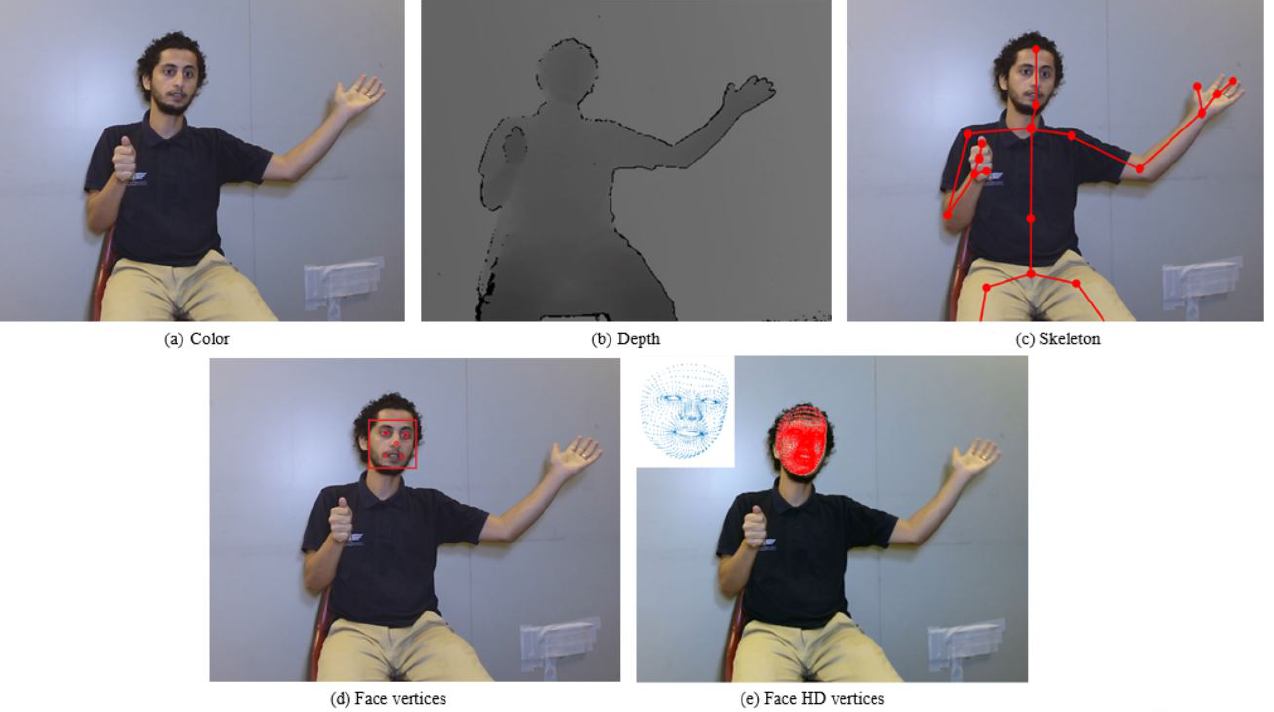
Figure 4. An illustrative example for the five modalities provided for each sign